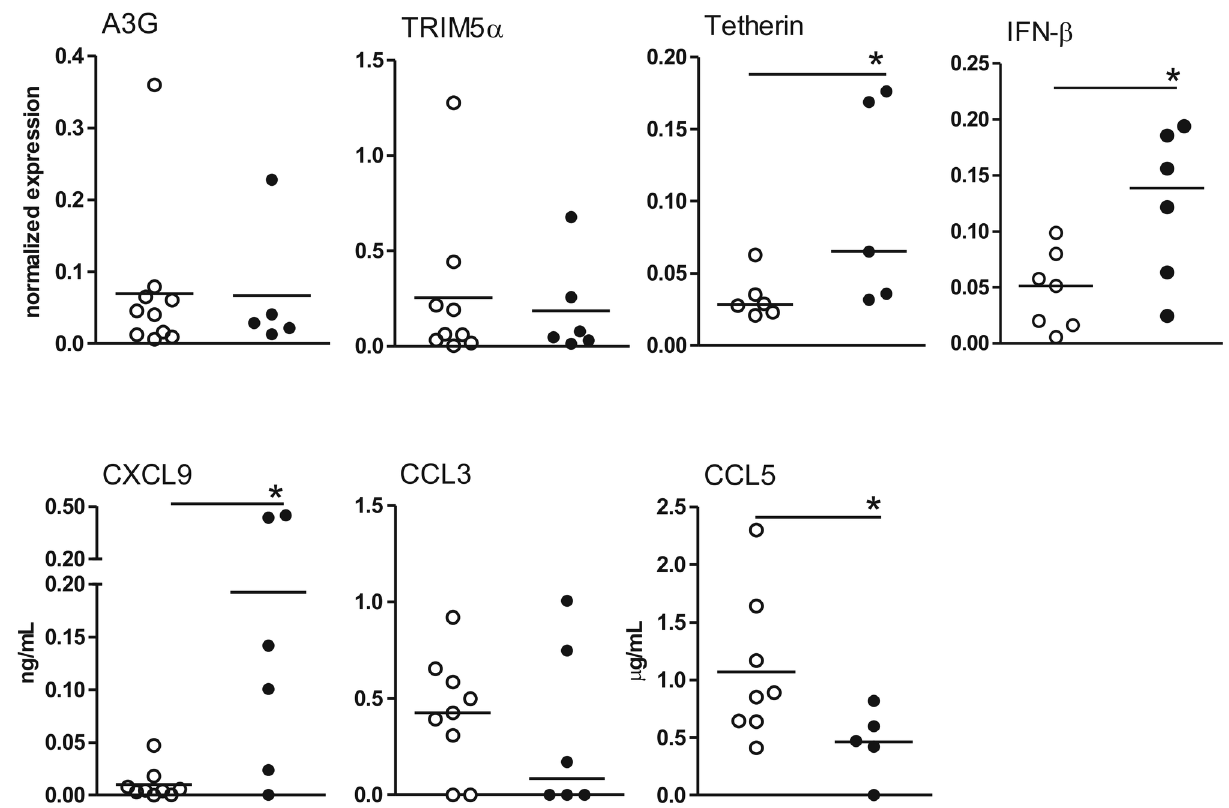
Figure 3. Extracellular and intracellular antiviral factors in colostrum from HIV-infected mothers and UN mothers. Colostrum samples were obtained up to 24 h after delivery from HIV-infected mothers (n=5-6) and UN mothers (n=9-10). The cells were evaluated by real-time PCR for A3G, TRIM-5α, tetherin and IFN-β mRNA expression or for CXCL9, CCL3 and CCL5 expression by flow cytometry. The data represent median values. *p≤0.05 compared with the control group. doi: